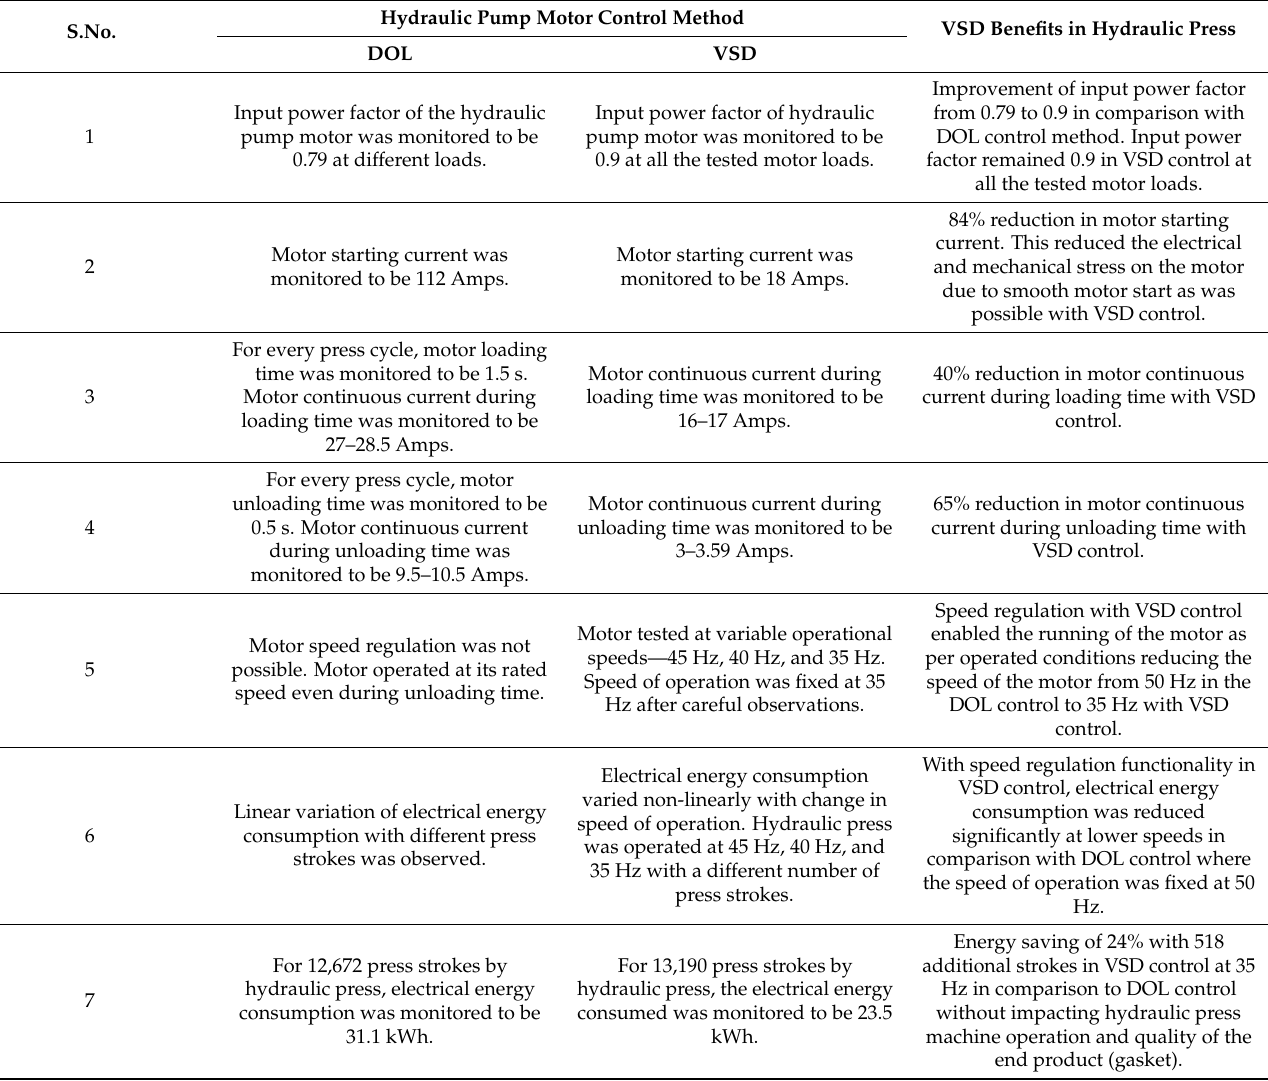
Table 5. Comparison of DOL and VSD control as per the proposed research work for the hydraulic